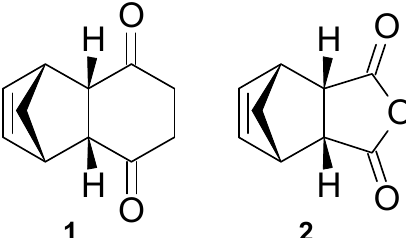
Figure 2. Tricyclo[6.2.1.0 2,7 ]undec-9-ene-3,6-dione- ( 1 ) and 4-oxatricyclo[5.2.1.0 2,6 ]dec-8-ene-3,5-dione ( 2 ) scaffolds.